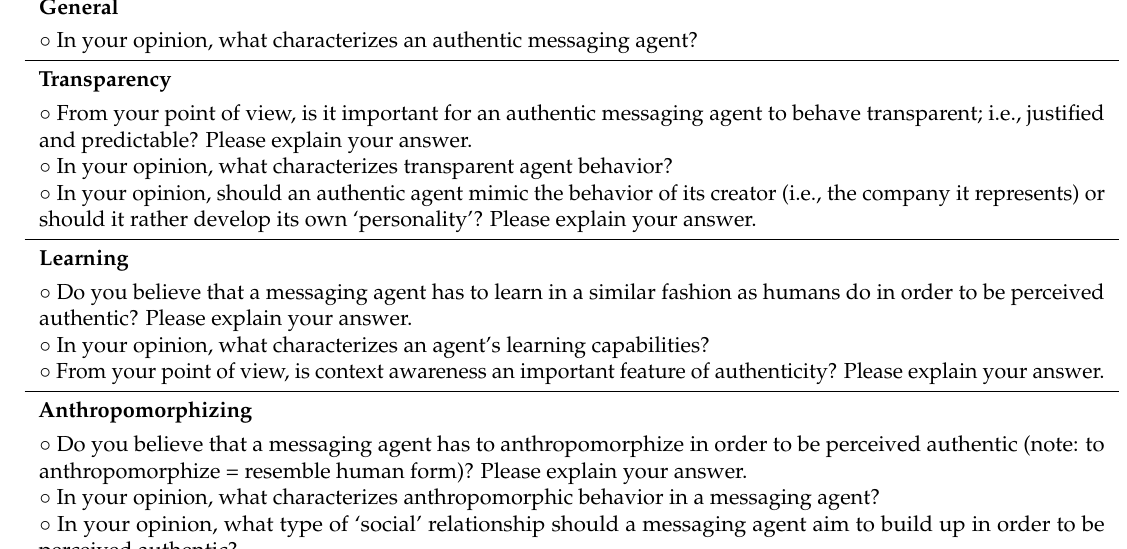
Table 7. Survey questions positioned along the identified five authenticity traits.